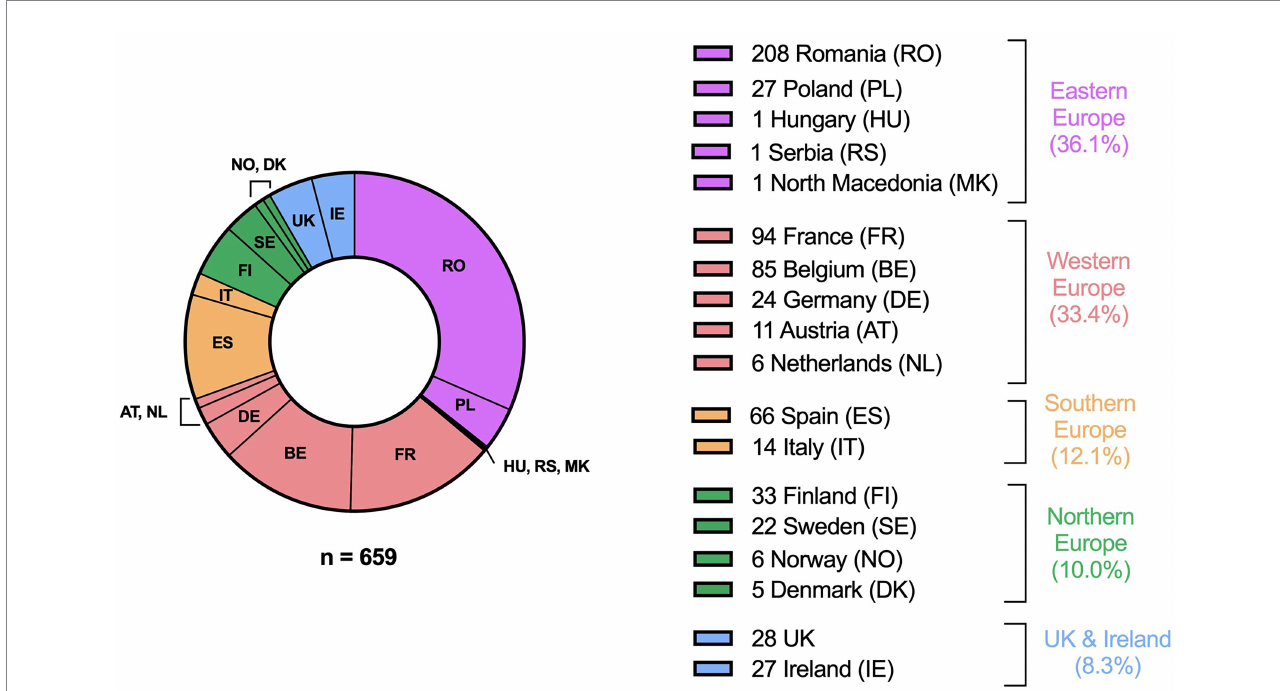
FIGURE 1 Origin of the respondents. Country groups are based on The United Nations Geoscheme, except for the UK and Ireland which were considered a separate sub-region due to the difference in health